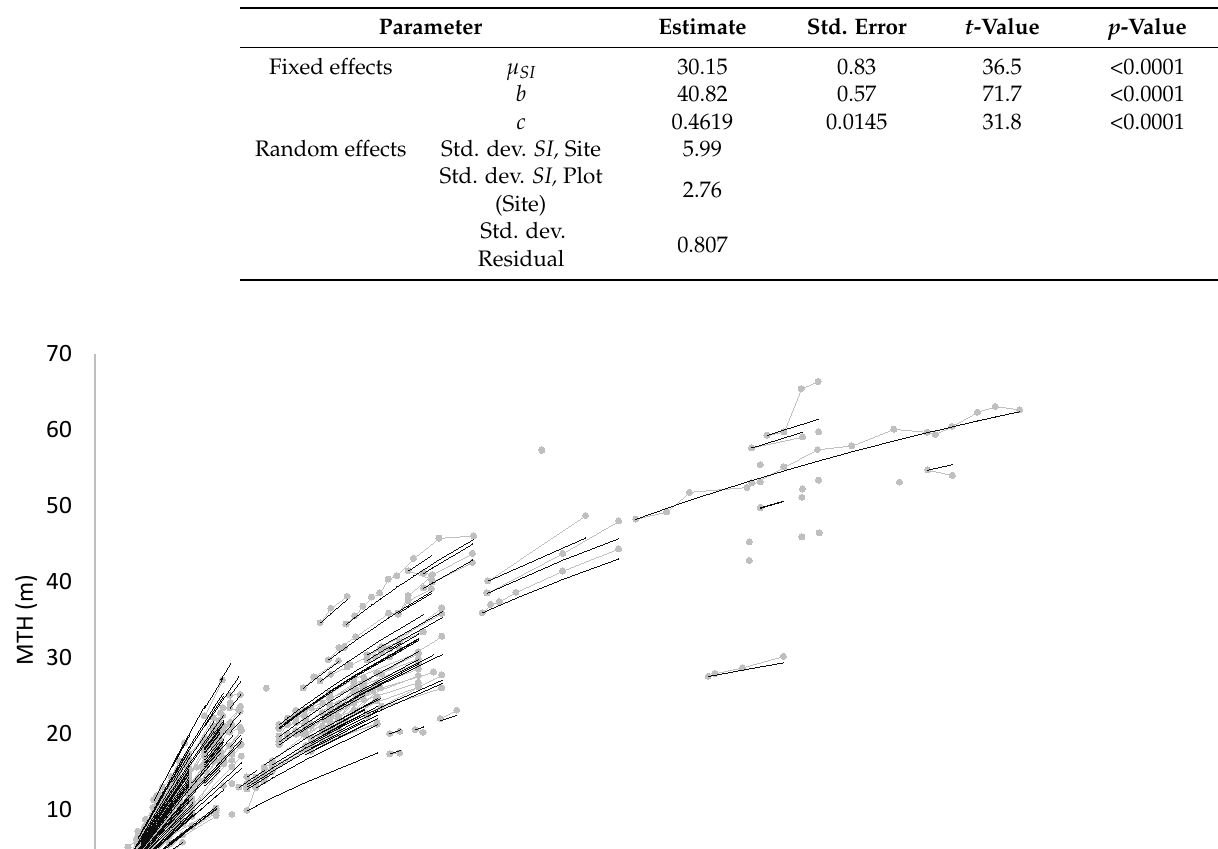
Table 4. Parameter estimates of the polymorphic Korf MTH model (Equation (15)).